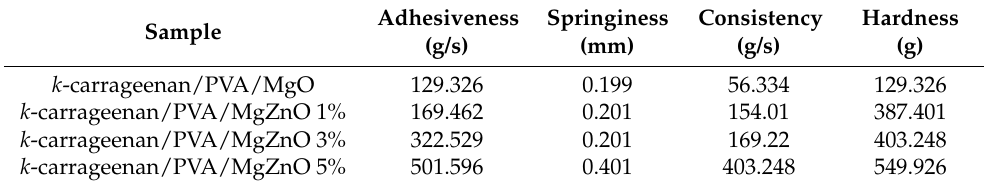
Figure 2. SEM images of k -carrageenan/PVA hydrogels containing MgZnO nanoparticles. ( a ) k - carrageenan/PVA/MgO, ( b ) k -carrageenan/PVA/MgZnO 1%, ( c ) k -carrageenan/PVA/MgZnO 3%, and ( d ) k -carrageenan/PVA/MgZnO 5%. Table 3. Compression test of k -carrageenan/PVA hydrogels containing MgZnO